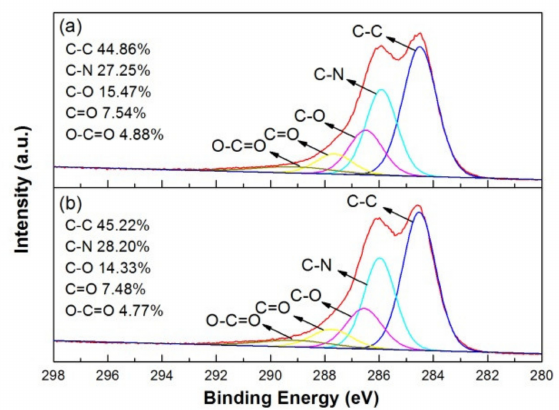
Figure 7. XPS C-1s spectrum and bonding ratio of ( a ) as-deposited and ( b ) 100 ◦ C-annealed rGO / PANI